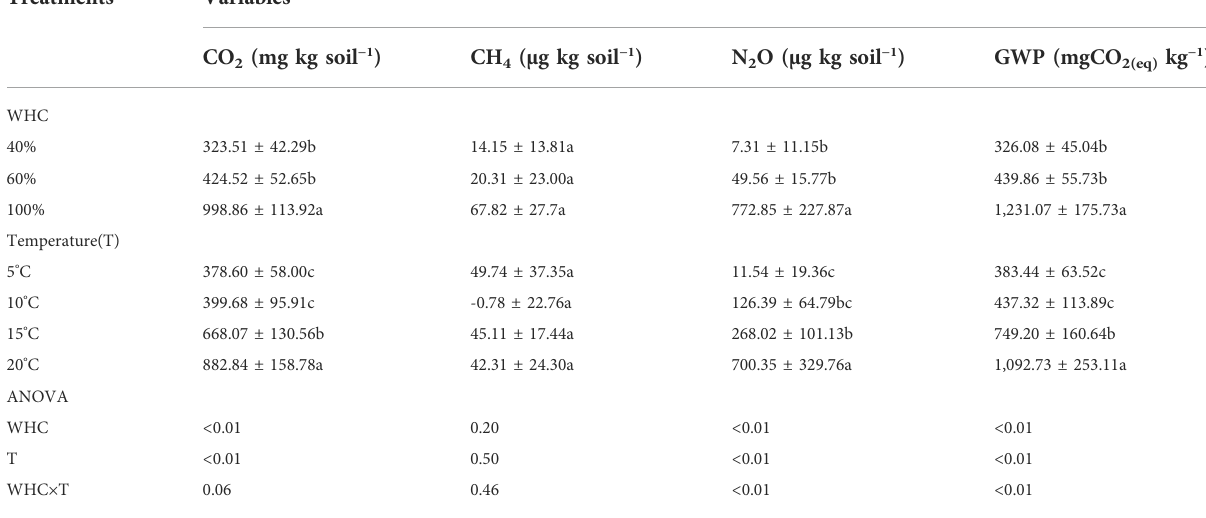
TABLE 1 Cumulative greenhouse gas emissions (means ±